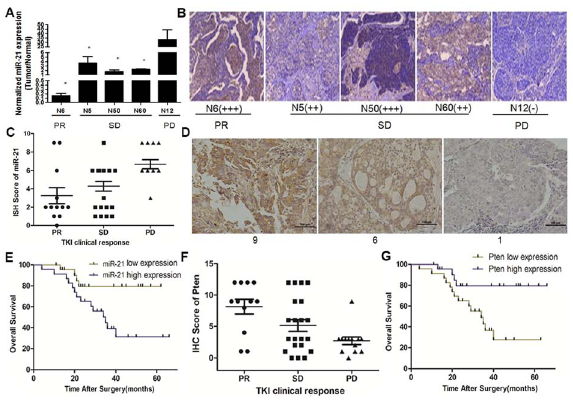
Figure 2. MiR-21/Pten expression levels and their relationship with TKI sensitivity and overall survival in NSCLC patients undergoing TKIs treatment. (A) Clinical response of TKI and miR-21 expression levels in 5 NSCLC patients evaluated by q-RT PCR. (B) Clinical response of TKI and Pten expression levels in 5 NSCLC patients tested by Immunohistochemistry. PR (partial response) and SD (stable disease) patients had relatively lower miR-21 expression levels and higher Pten expression levels compared with PD (progressive disease) patients. (* p , 0.05). (C) Correlation analysis performed between miR-21 expres- sion levels and clinical response to TKIs. (D) Representative miR-21 levels and scores in NSCLC tissues undergoing TKI treatment evaluated by in situ hybridization. (E) Kaplan-Meier curves depicting overall survival according to expression of miR-21 in 46 NSCLC patients undergoing TKIs treatment. (F) Correlation analysis performed between Pten expression levels and clinical response to TKIs. (E) Kaplan-Meier curves depicting overall survival according to expression of Pten in 46 NSCLC patients undergoing TKIs treatment.